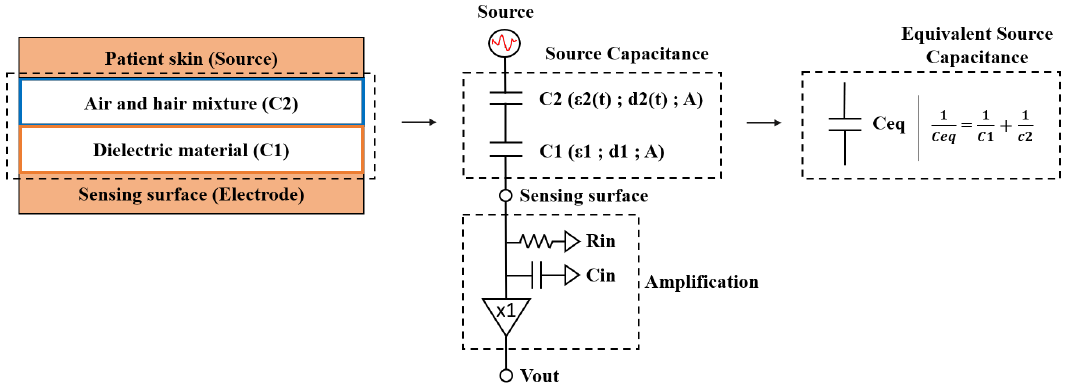
Figure 1. Capacitive coupling of skin biopotentials and